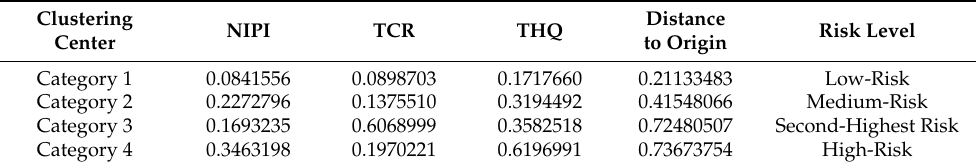
Table 5. Clustering center of the assessment indexes (normalized); based on the Euclidean distance between each cluster center and the origin, the cluster centers are marked as different risk levels.